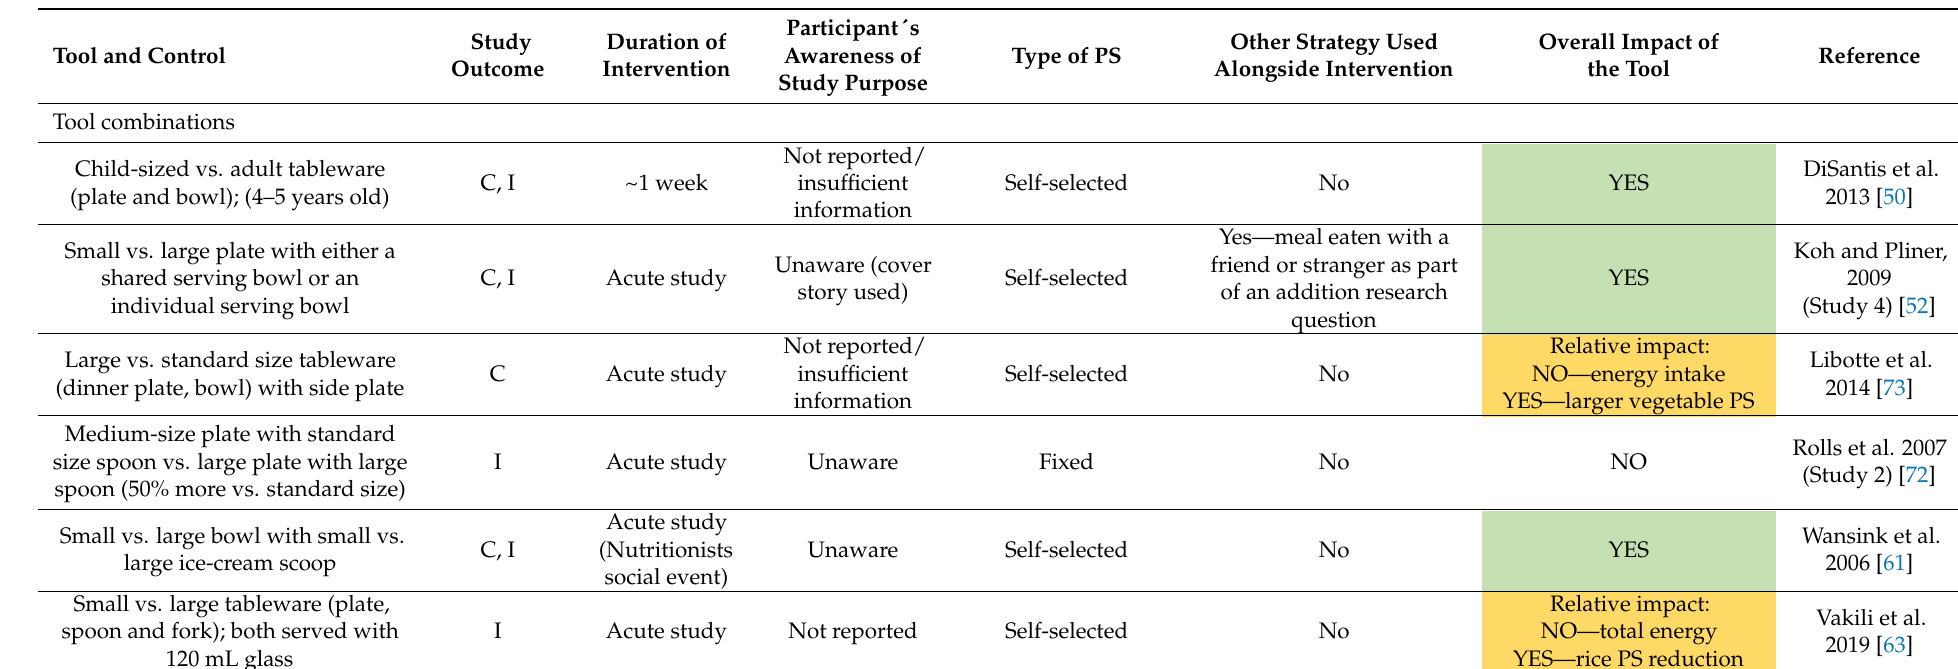
Tool combinations Child-sized vs. adult tableware (plate and bowl); (4–5 years old) Small vs. large plate with either a shared serving bowl or an individual serving bowl Large vs. standard size tableware (dinner plate, bowl) with side plate Medium-size plate with standard size spoon vs. large plate with large spoon (50% more vs. standard size) Small vs. large bowl with small vs. large ice-cream scoop Small vs. large tableware (plate, spoon and fork); both served with 120 mL